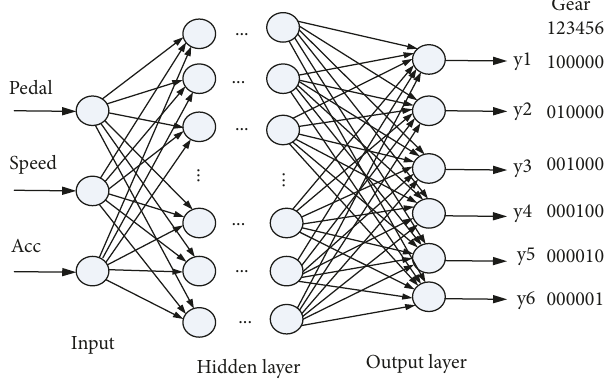
Figure 4: Three-parameter neural network